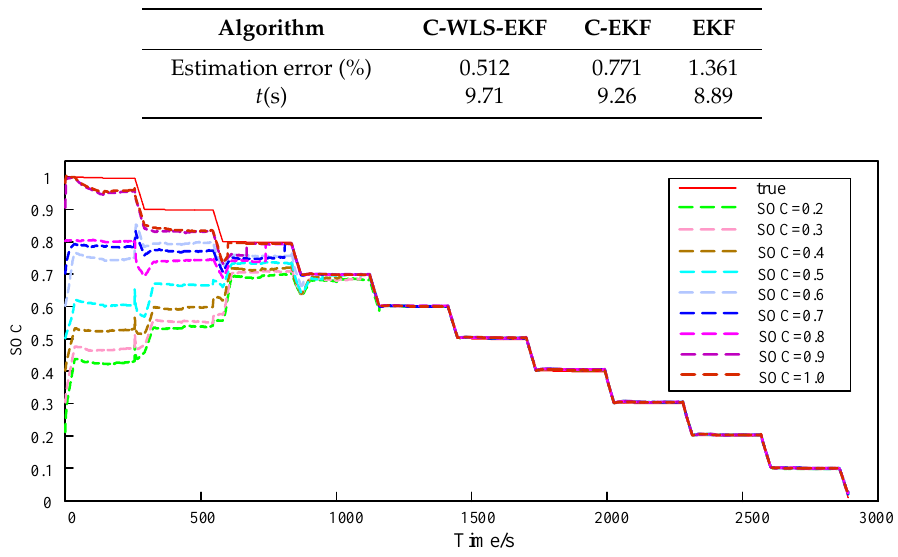
Figure 11. Estimated results under different initial SOCs.